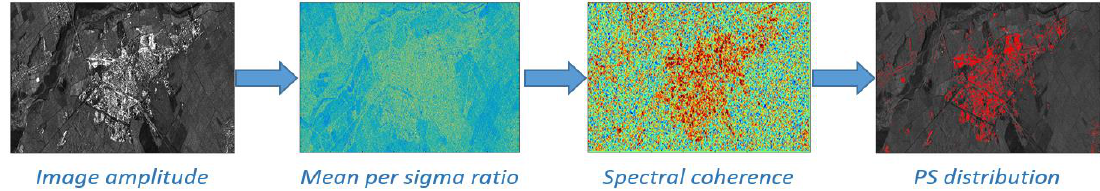
Figure 2. Visual representation of Persistent Scatterers detection algorithm.